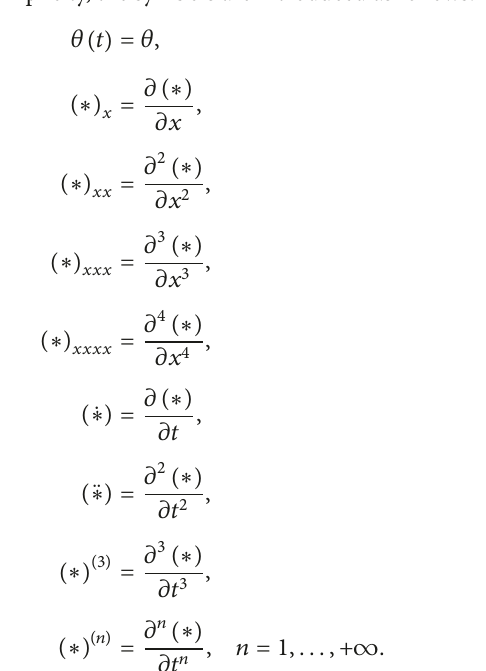
flexible manipulator is subject to small elastic deformation and considered as an Euler-Bernoulli beam. As shown in Figure 1, XOY and xoy are the global frame and the local frame fixed on the body center, respectively; 𝑑 1 (𝑡) and 𝑑 2